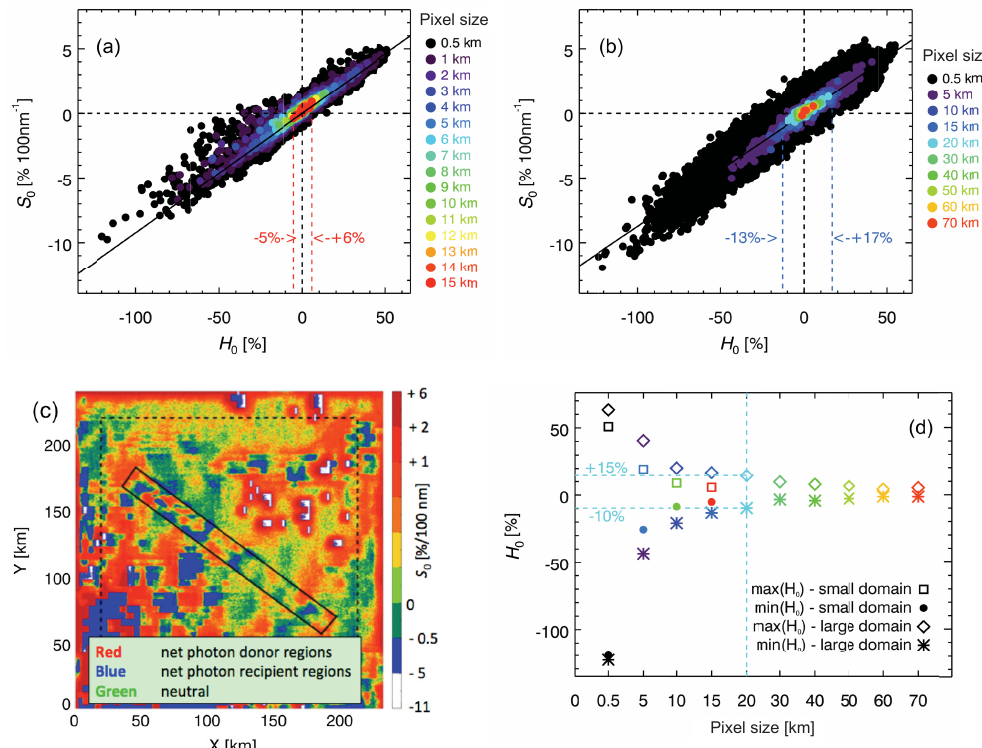
Figure 8. Scatter plot of S 0 vs. H 0 as obtained from linear regression of Eq. (12) for (a) the small domain from Fig. 1 and (b) the large-scale domain from Fig. 2, spatially aggregated to different scales, including the 20km super-pixels as highlighted in Fig. 2 (red squares). The dashed lines indicate the range for 15km pixels. (c) Spatial distribution of S 0 from (b) . Red (blue) indicates net photon donor (recipient) pixels, and green “neutral zones” ( H λ ≈ S 0 ≈ 0). (d) Dependence of max( H) and min( H) on spatial aggregation scale (km). The color is the same as in (b)